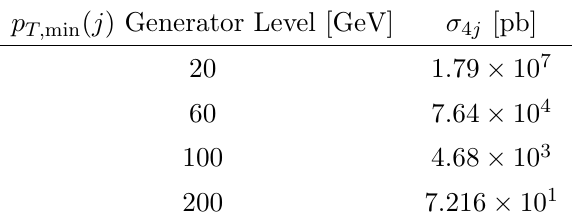
p s = 13 TeV with